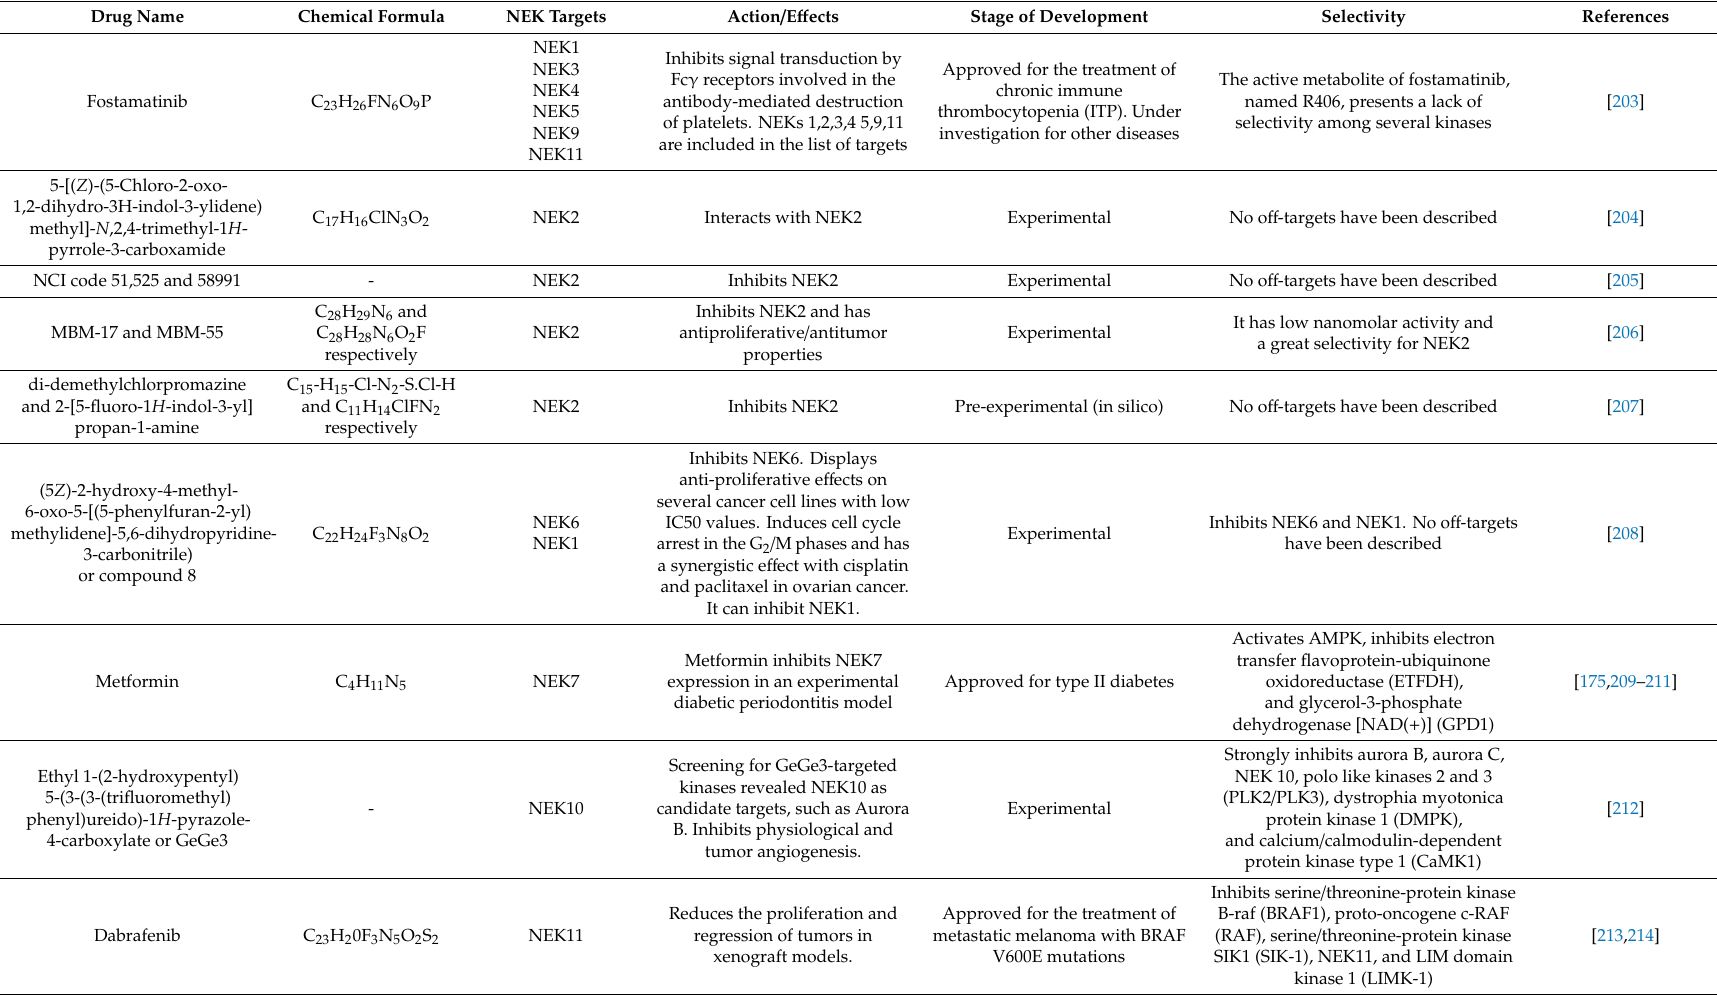
Table 1. Drugs and inhibitors of NEK family